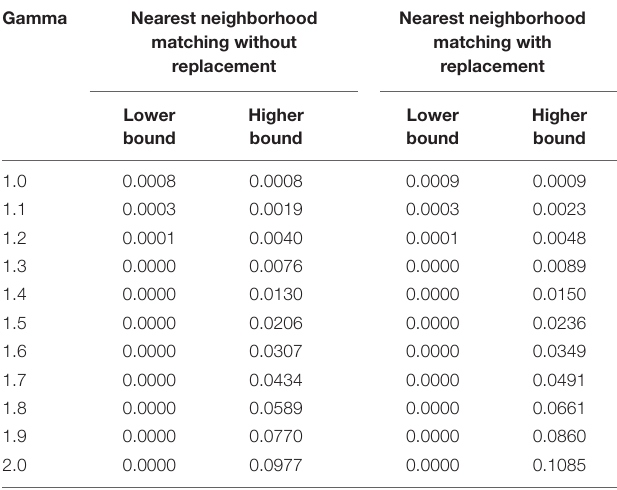
TABLE 9 | Results of the Rosenbaum’s sensitivity analysis for the Wilcoxon’s signed rank test. Gamma Nearest neighborhood matching